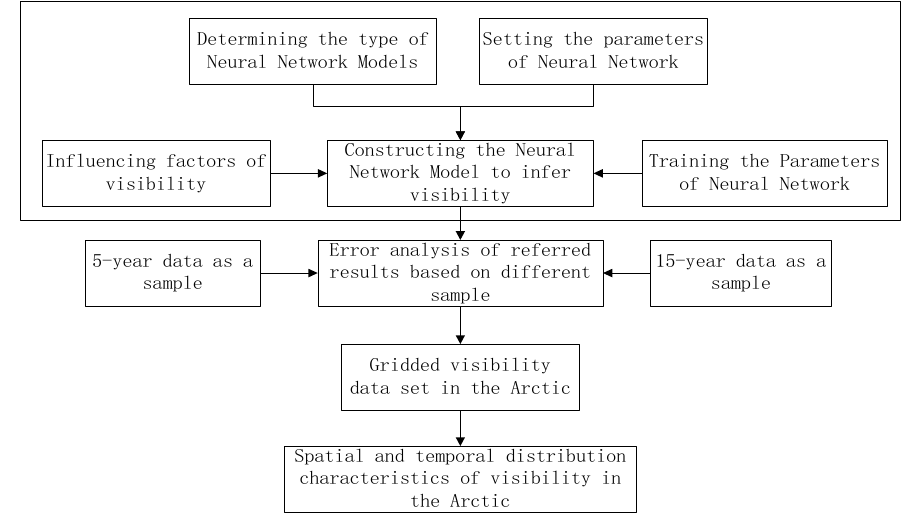
Figure 2. Technical flowchart.